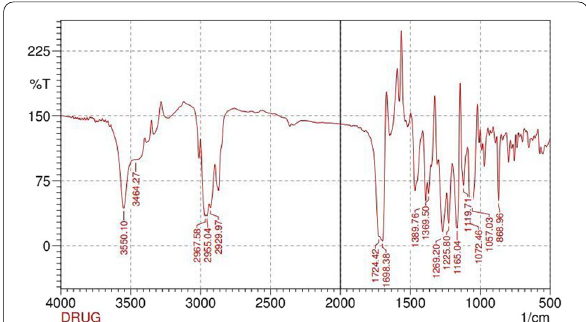
Fig. 3 Fourier transform infrared spectroscopy report of cilnidipine. The peak positions of cilnidipine are represented in wave numbers